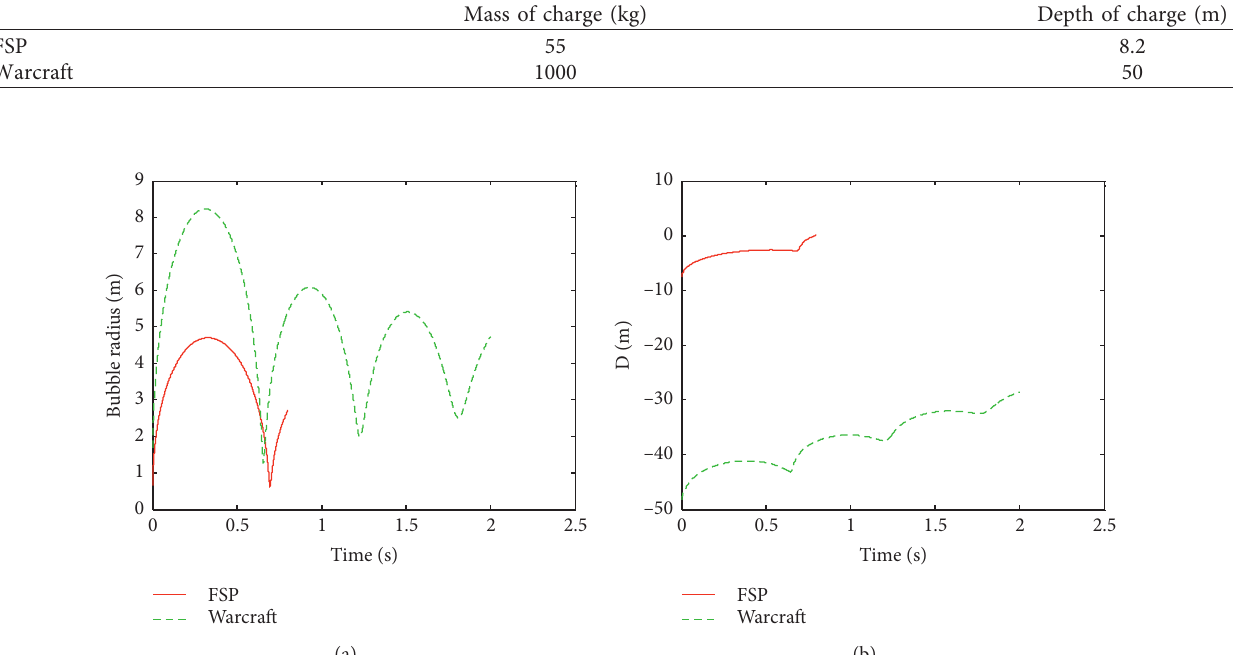
Figure 4: Comparison of bubble motion between FSP and warcraft under typical working conditions. (a) Bubble radius. (b) Distance from bubble top surface to free surface.